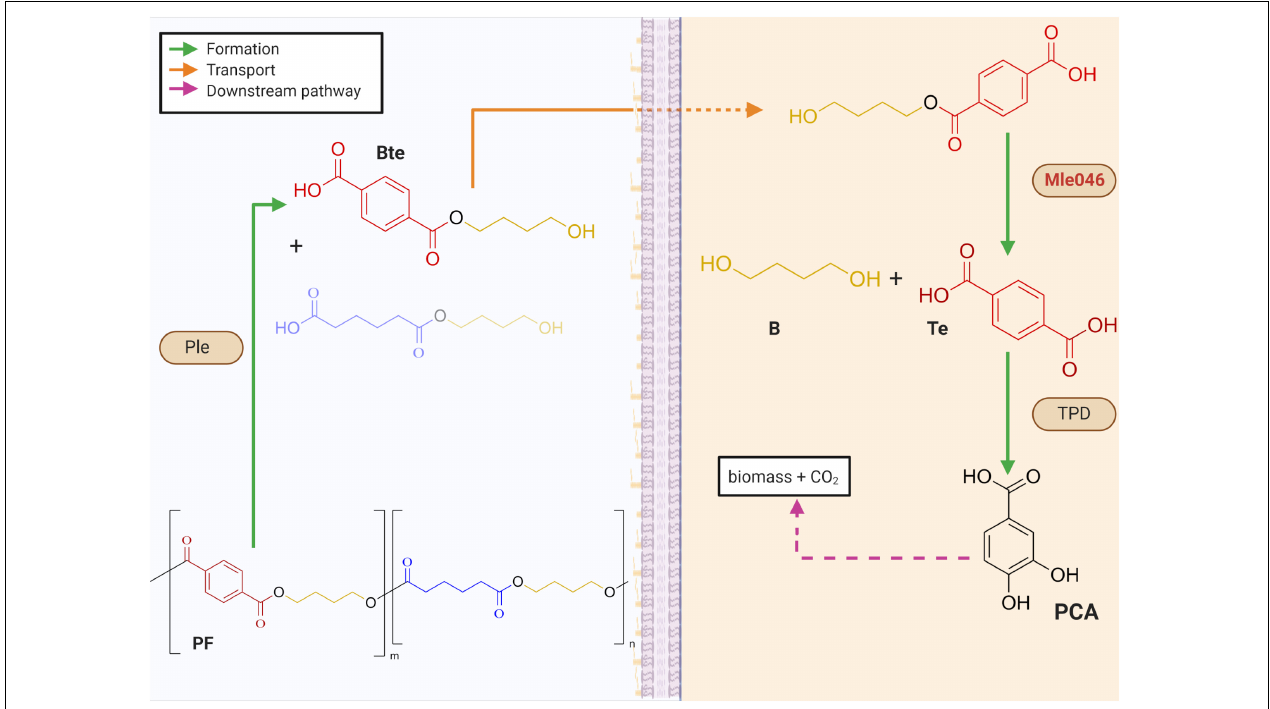
FIGURE 1 | Mechanisms for the biodegradation of a PBAT-based blend film (PF) within a biofilm. Periplasmatic α / β hydrolases (Ples) cleave the PF to produce oligomers of 1,4-butanediol (B) with either terephthalic acid (Te) or adipic acid. Mles (e.g., Mle046 shown in red) hydrolyzes inside the cell a mixture of terephthalate-butanediol monoester (Bte) that yields Te and B. Te is further degraded by a Te degradation cluster (TPD). Downstream degrading enzymes lead to the formation of protocatechuate (PCA) which can be further degraded to biomass and CO 2 . Green arrows indicate the formation of intermediates after enzymatic catalysis; orange arrows show the transport of intermediates to the cell; pink-dashed arrows indicate downstream degradation pathways (created with